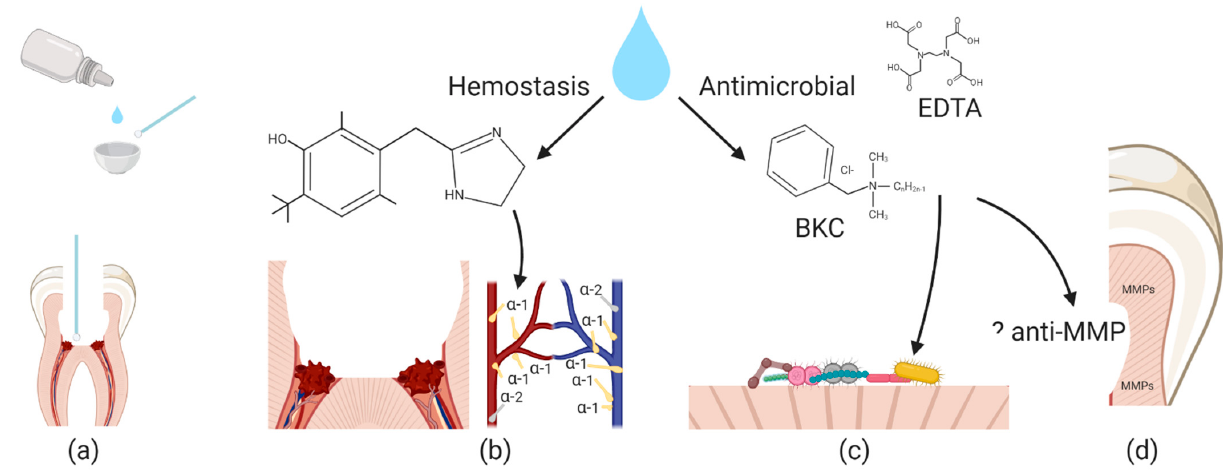
Figure 3. Conceptual Model of Imidazoline Activity. ( a ) Volume dosing of ImDs and use of microbrush to deliver solution to exposed pulp chambers. ImD solutions have possible multi-modal action ( b ) ImDs (oxymetazoline shown) are agonist to α -1 adrenoreceptors found in pulp tissue and innervation of these receptors can initiate vasoconstriction and hemostasis. ( c ) benzalkonium chloride (BKC) and EDTA work together to disrupt bacterial membranes and cationic properties can also aid in debris removal. Benzalkonium chloride is often a mixture of different chain length alkylbenzyldimethylammonium chlorides ( n = 8, 10, 12, 14, 16, 18) ( d ) There is a hypothetical mechanism that BKC may inhibit dentine matrix metallopro- teinase (MMPs) that can degrade a future dentin-adhesive layer. While hemostasis and antimicrobial action have extensive evidence, the MMP activity is based on limited studies and requires more